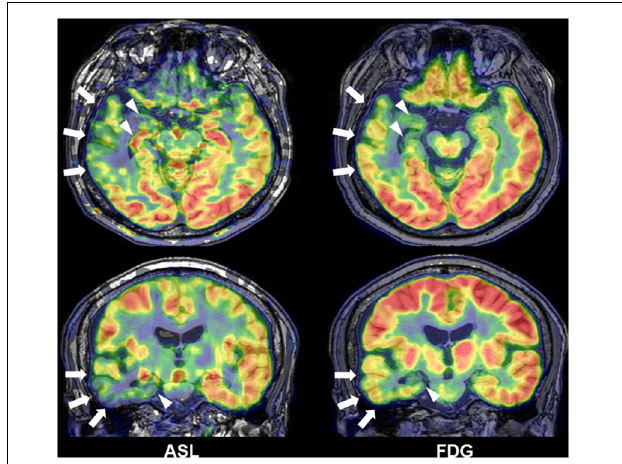
FIGURE 7 | A case of temporal lobe epilepsy with hippocampal sclerosis. Both Arterial spin labeling (ASL) and 18F-FDG PET showed reduced signals around the temporal lobe of focus side (modified from Sone et al.,